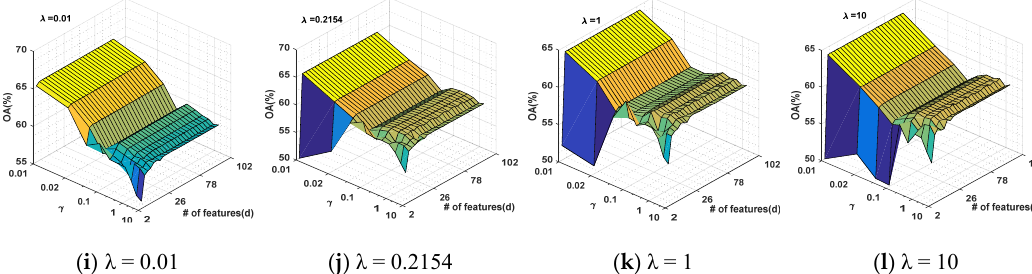
Figure 9. OA versus the number of features d, the SVM parameter γ , and the regularization factor λ of JTM for ROSIS data sets (University → Center). ( a ) OA versus γ and λ , d = 2; ( b ) OA versus γ and λ , d = 6; ( c ) OA versus γ and λ , d = 10; ( d ) OA versus γ and λ , d = 102; ( e ) OA versus λ and d, γ = 0.01; ( f ) OA versus λ and d, γ = 0.2154; ( g ) OA versus λ and d, γ = 1; ( h ) OA versus λ and d, γ = 10; ( i ) OA versus γ and d, λ = 0.01; ( j ) OA versus γ and d, λ = 0.2154; ( k ) OA versus γ and d, λ = 1; ( l ) OA versus γ and d, λ = 10.